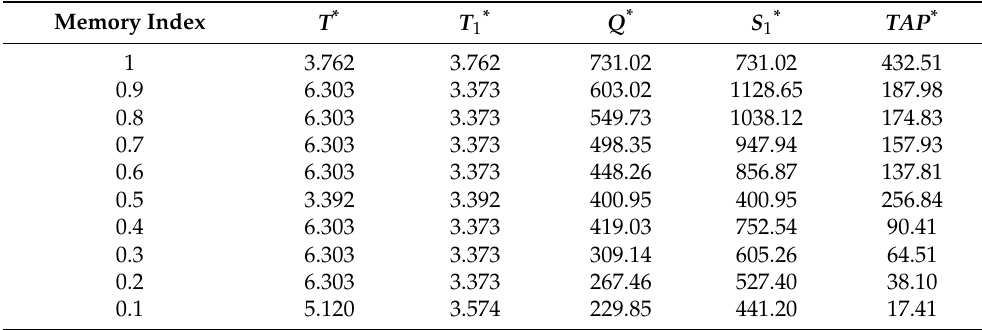
Figure 2. Flow chart of the solution algorithm for numerical simulation of the proposed model. Table 4. Impact memory on optimum values of the objective function total average profit ( TAP ∗ ), and decision variables, namely.initial inventory level ( S 1 ), lot size ( Q ), active inventory run phase ( T 1 ), total lot cycle ( T ) for the model with